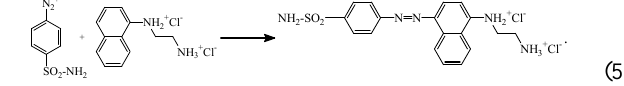
Fig. 1. Schematic setup of the NO 2 -LOPAP instrument. Fig. 1: Schematic setup of the NO HONO (Milani and Dasgupta, 2001) and ozone interfer- ences (Adema, 1979) by the Griess-Saltzman reaction are